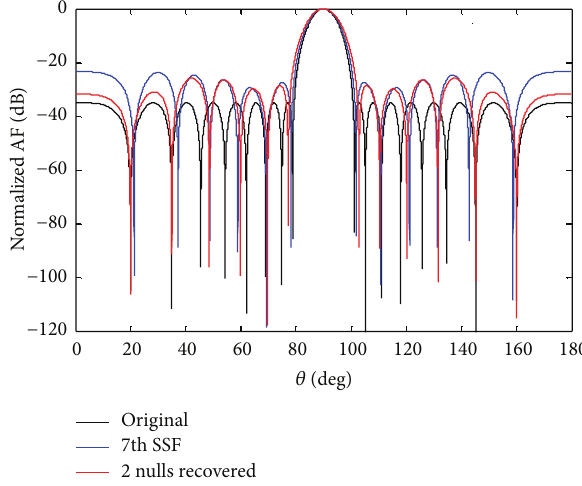
Figure 5: The original radiation pattern, the 𝑤 7 SSF, and recovery of one null.